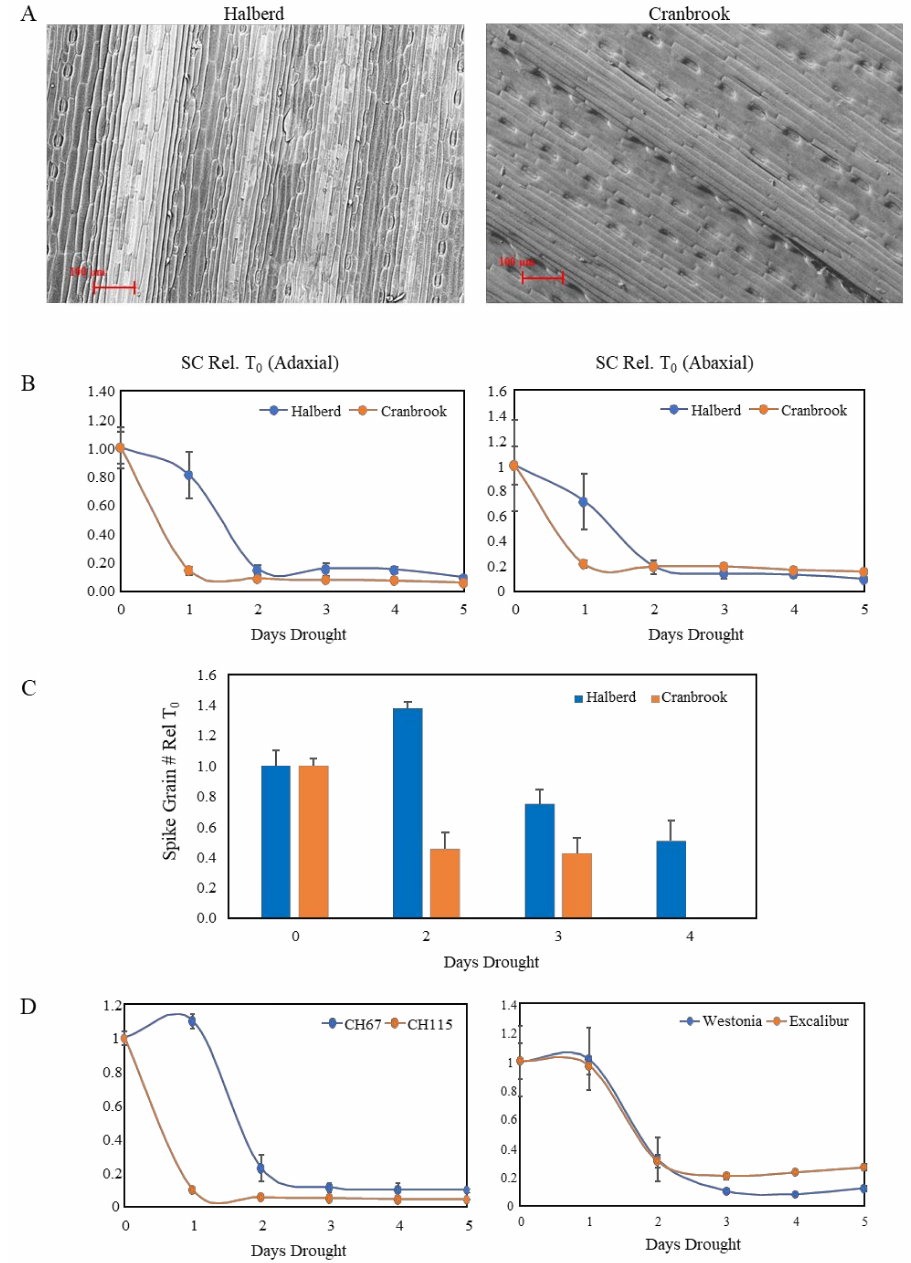
Figure 2. ( A ) Scanning electron microscope pictures of Cranbrook and Halberd flag leaves. The pictures were used to measure stomatal density and length of the guard cells using Fiji software. ( B ) Stomatal conductance (SC) measurements of Cranbrook and Halberd flag leaves over a period of 5-days of drought treatment. Five porometer readings were taken at each time point and results were averaged (error bars are standard errors). The data are expressed relative to the T 0 unstressed control plants. ( C ) Effect of drought stress on Cranbrook and Halberd spike grain numbers. Plants from the 5-day drought time course experiment were re-watered at different time points and allowed to develop to maturity. Spike grain numbers were determined for 5-10 spikes per time point and spike grain numbers were expressed relative to unstressed T 0 numbers. Error bars represent standard errors. ( D ) SC measurements for a 5-day drought stress time course experiment for a drought-tolerant (CH67) and a drought-sensitive (CH115) tail line of a Cranbrook × Halberd DH population (left) and two additional wheat varieties with known reproductive stage drought tolerance (Excalibur and Westonia;